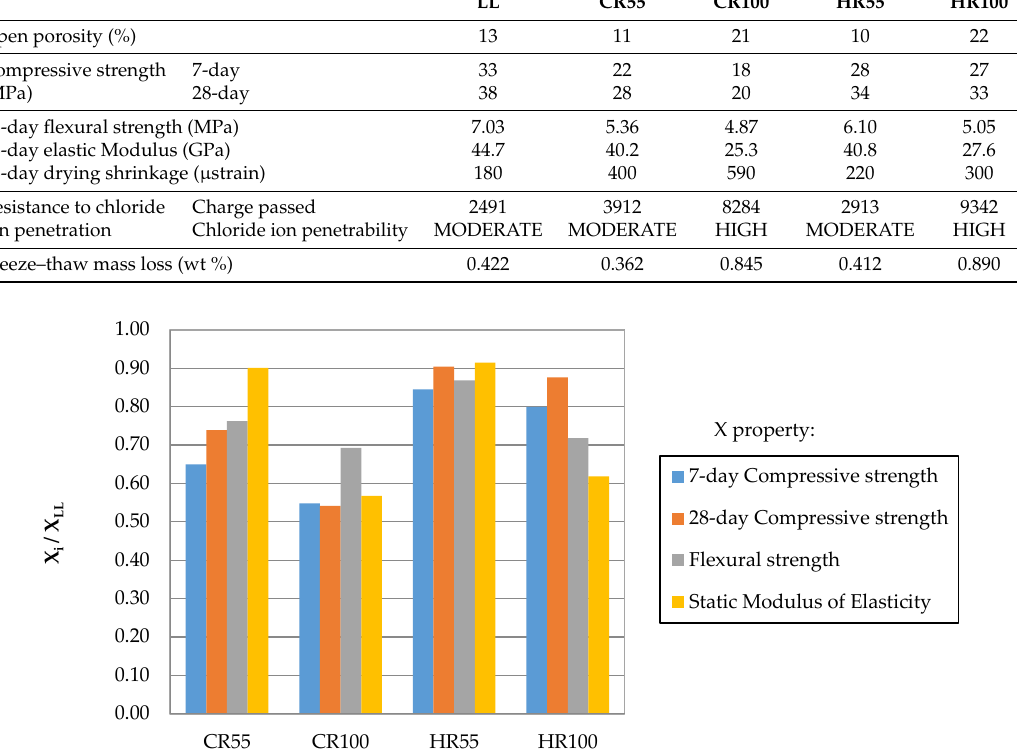
Figure 10. Comparison of various properties of mixtures (X) with the reference concrete (X LL ).